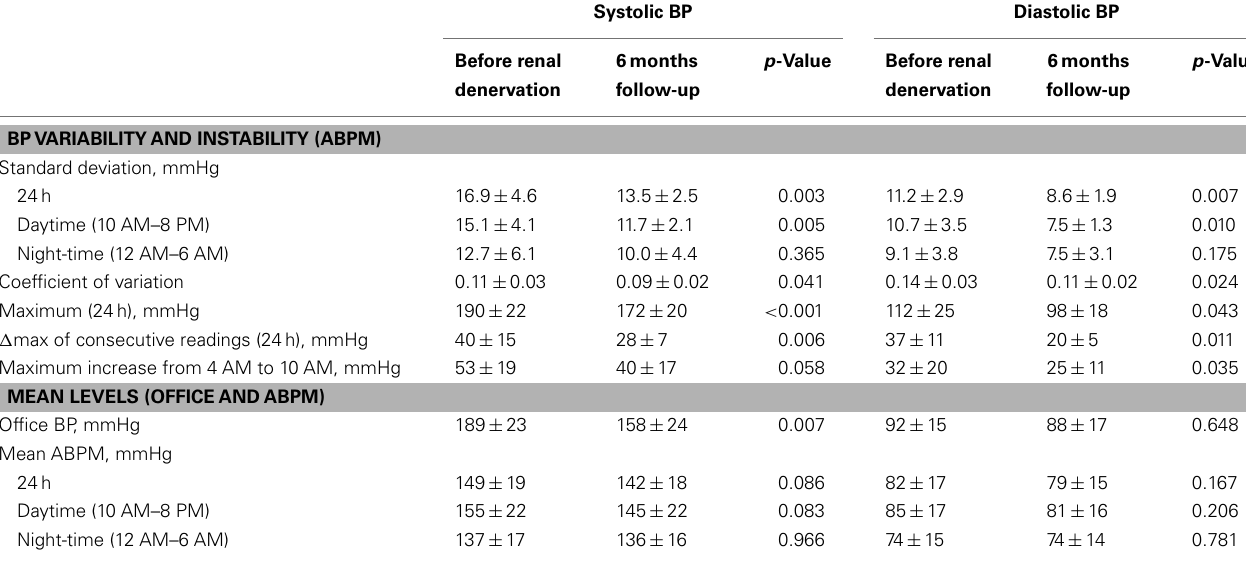
Table 3 | BP variability, instability, and mean levels of BP at baseline and 6months after